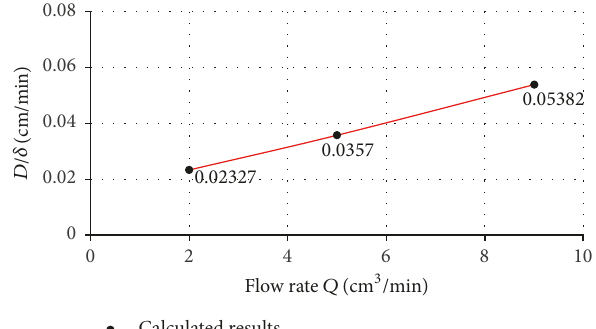
Figure 5: Comparison of the calculated results and test data of the transient dissolution of rock salt at 𝑄 = 5 cm 3 min −1 .